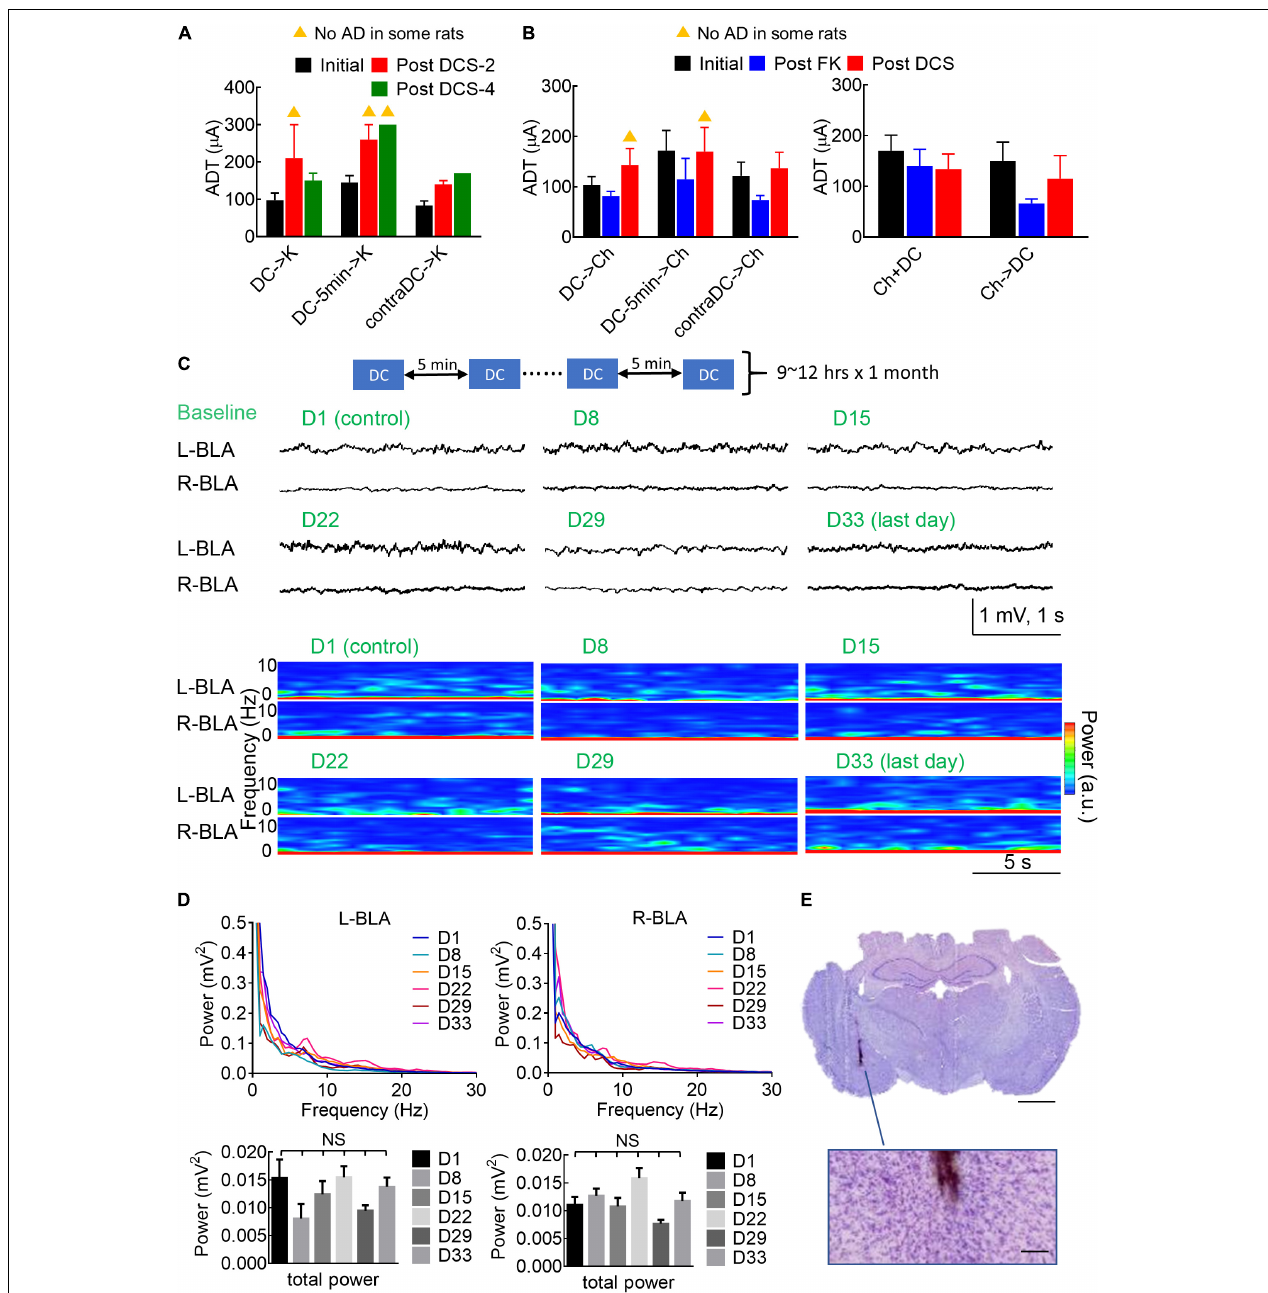
FIGURE 9 | Long-lasting anti-ictogenic effect and long-term safety of DCS. (A) The initial ADT denotes the threshold for elicitation of AD. The post DCS-2 and post DCS-4 ADT denote the threshold for the elicitation of AD, 2 and 4 weeks after the initial ADT, respectively, with DCS given immediately before the kindling (DCS → K, n = 4) or 5 min before kindling (DCS → 5 min → K, n = 4), or immediately before kindling to the contralateral side (contraDCS → K, n = 3). The yellow triangle denotes that no AD could be elicited in some rats. There is a clear trend that the post-DCS-2 or post-DCS-4, ADT is higher than the initial ADT. (B) The post-FK ADT denotes the threshold for elicitation of AD 10 days after the rat was fully kindled. The FK rats then underwent a 4-day challenge stimulation preceded by different forms of DCS analogous to part (A) (left: DCS → Ch, n = 6, DCS → 5 min → Ch, n = 5, contraDCS → Ch, n = 6; right: Ch + DCS, Ch → DCS, both n = 6). The post-DCS ADT denotes the threshold for the elicitation of AD roughly 10 days after the DCS treatment. In this study, is a tendency that the post-DCS ADT is higher than the post-FK ADT if DCS were given before kindling and challenging stimulation. (C) Repeated sessions of in situ DCS (100 µ A × 10 s) were applied to the left basolateral amygdala (L-BLA) every 5 min, 9–12 h a day for 1 month. The baseline electrophysiological activities [LFP recordings and spectrogram analysis] of bilateral BLAs remain rather similar from day 1 to day 33. (D) The mean power spectrum densities (PSD, upper) and total power (0.5–100 Hz, lower) of 1 min baseline recordings at bilateral BLAs remain the same from day 1 to day 33 ( n = 6 each day in 2 rats). NS: p ≥ 0.05, Wilcoxon matched-pairs signed-rank test. (E) Histological examination with Nissl stain shows no apparent tissue damage in the vicinity of the electrode (the brown trace). The scale bar is 2 mm (or 0.2 mm for the enlarged